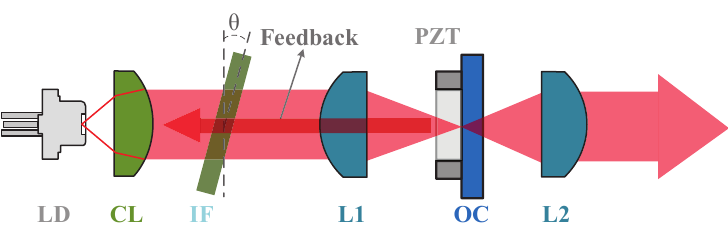
Figure 1. Schematic of interference-filter external-cavity diode laser (IF-ECDL). LD: laser diode; CL: collimating lens; IF: interference filter; L1: cat’s-eye lens; PZT: piezotube; OC: partially reflective out-couple mirror; L2: re-collimating